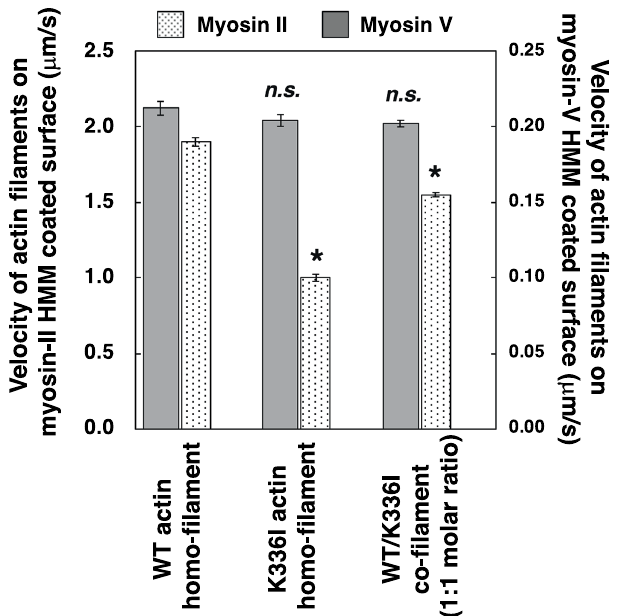
Figure 3. Sliding velocities of K336I and WT actin filaments on myosin II-HMM and myosin V-HMM. Velocities (mean ± SE) on surfaces of myosin II-HMM were as follows: K336I homo-filaments, 1.00 ± 0.02 µ m/s ( N = 137); WT homo-filaments, 1.90 ± 0.03 µ m/s ( N = 110); and K336I/WT co-filaments, 1.55 ± 0.03 µ m/s ( N = 165). Velocities on surfaces of myosin V-HMM were as follows: K336I homo-filaments, 0.204 ± 0.003 µ m/s ( N = 40); WT homo-filaments, 0.212 ± 0.004 µ m/s ( N = 40); and K336I/WT co-filaments, 0.202 ± 0.002 µ m/s ( N = 40). Asterisks indicate a statistically significant difference compared to WT homo-filaments ( t -test, p < 0.001). Statistically insignificant differences are indicated by “ n.s